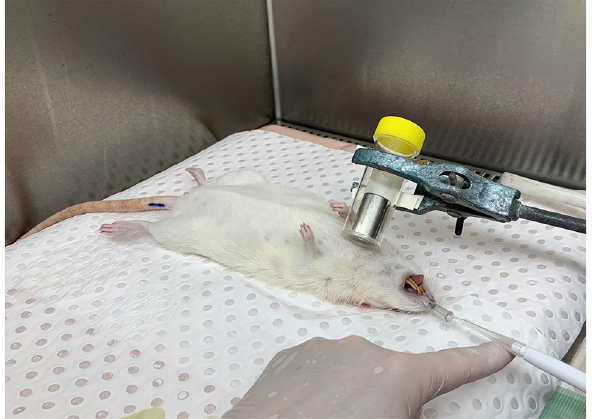
Figure 4. LV-MP delivery setup in a biosafety cabinet. The light grey Luer hub of the ET tube can be seen projecting from the mouth, with the pipette gel-tip shown inserted into the trachea to the desired depth via the ET